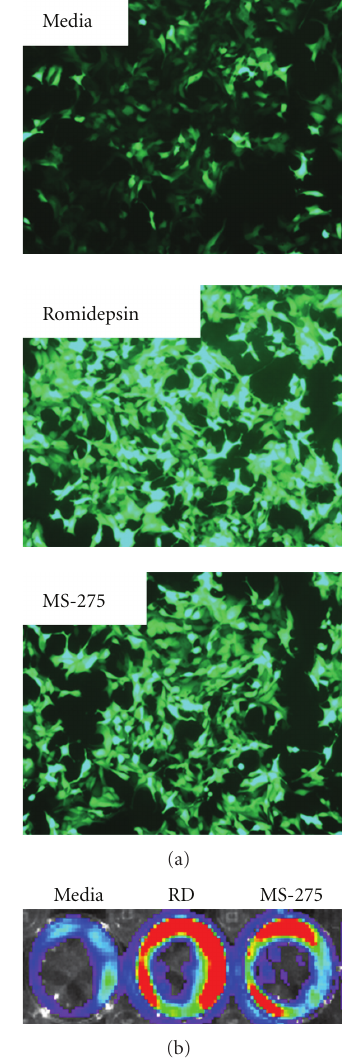
Figure 7: The e ff ect of HDACi on gene expression in 22Rv1 cells. (a) 22Rv1 cells were transduced with 10 multiplicities of infection with AdGFP in the absence or presence of 250 ng/mL Romidepsin or 1 µ M MS-275. Fluorescent images were collected 24 hrs after viral transduction (magnification = 200x). (b) 22Rv1 cells were transfected with pCMV.luc. The luciferase signal was quantified 48hrs after transfection in the absence or presence of 100 ng/mL romidepsin (RD) or 1 µ M MS-275. The photograph is a false color image of three representative wells indicating relative numbers of photons produced during a timed interval after luciferin addition. Red indicates more photons; blue indicates less